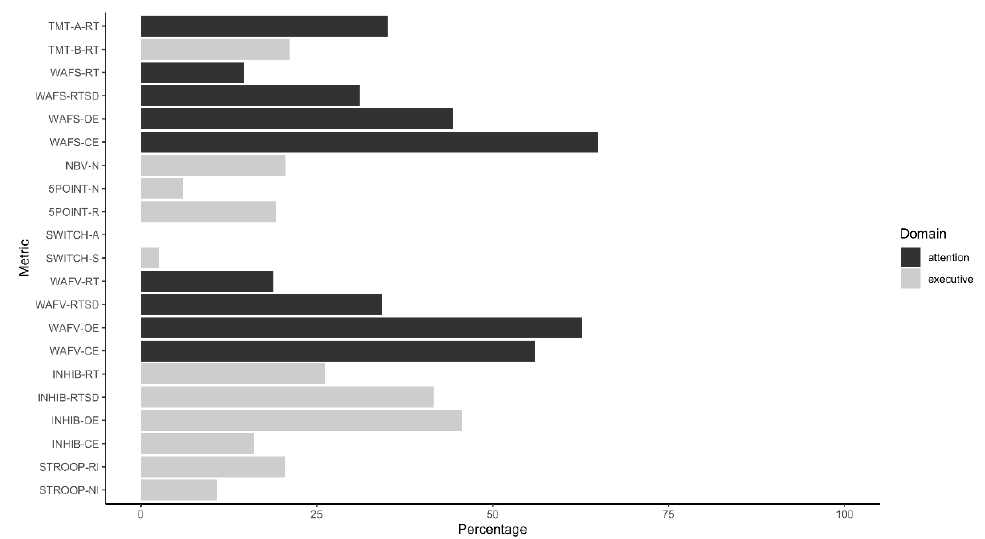
Figure 1. Percentage of instructed simulators detected by cut-off scores.